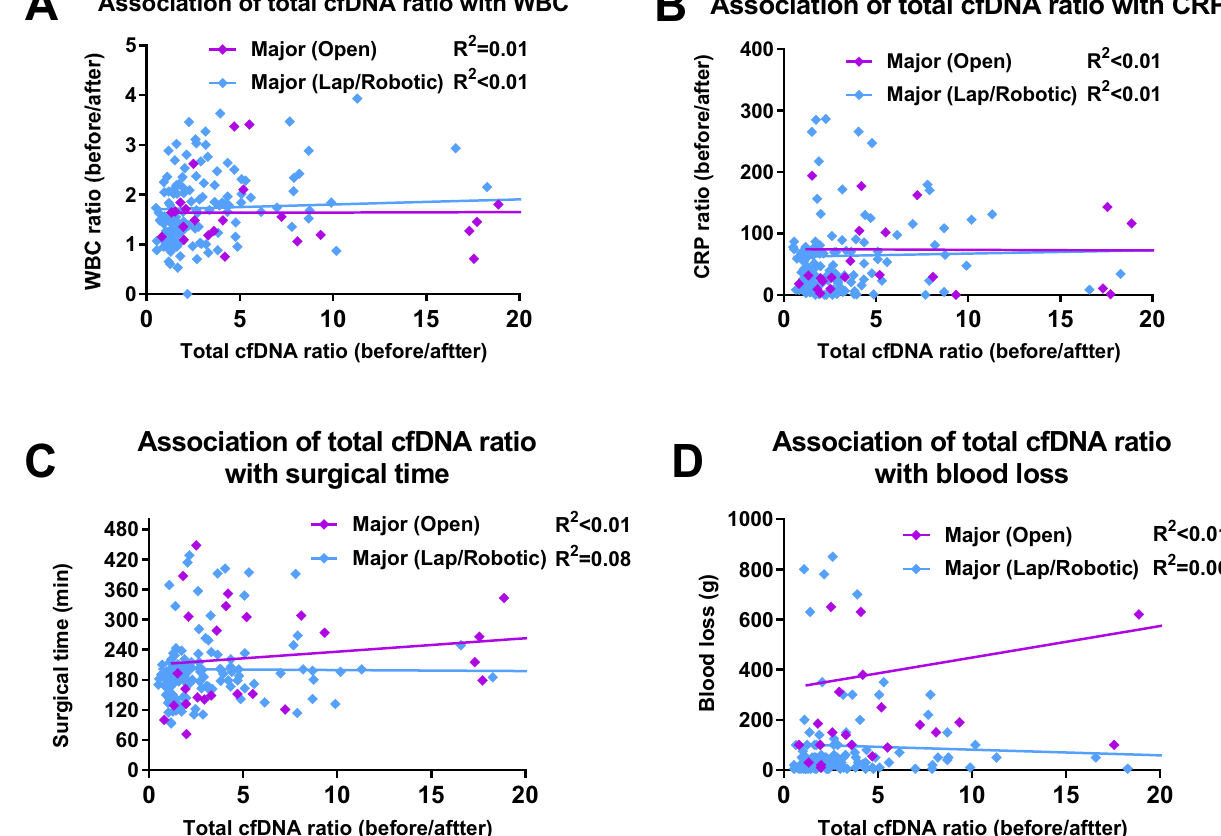
Figure 4. Pearson correlation plots of cell-free DNA ratio before and after surgery with conventional markers. A linear relationship between the cell-free DNA increasing ratio and conventional markers by scatterplot and linear regression analysis with correlation coefficient R. Markers examined were WBC ratio (before and after surgery) ( A ), CRP ratio (before and after surgery) ( B ), surgical time ( C ) and blood loss ( D